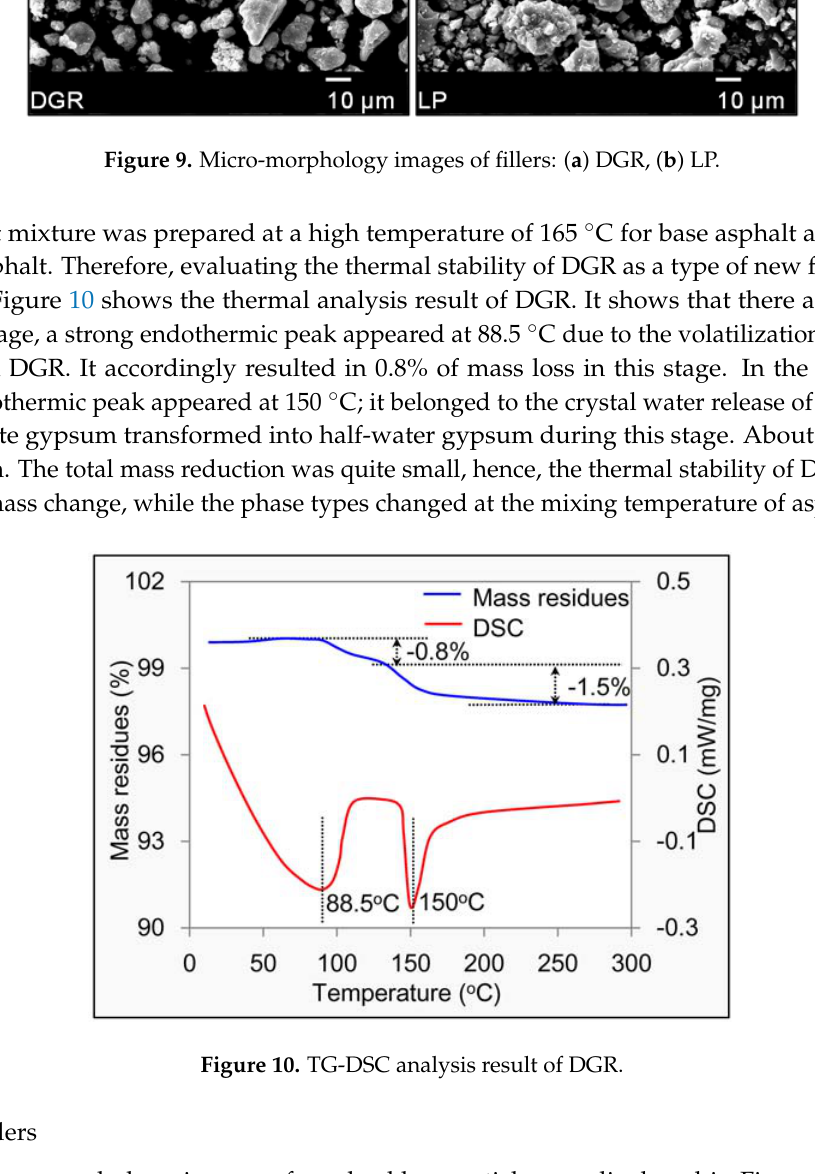
Figure 9. Micro-morphology images of fillers: ( a ) DGR, ( b ) LP.